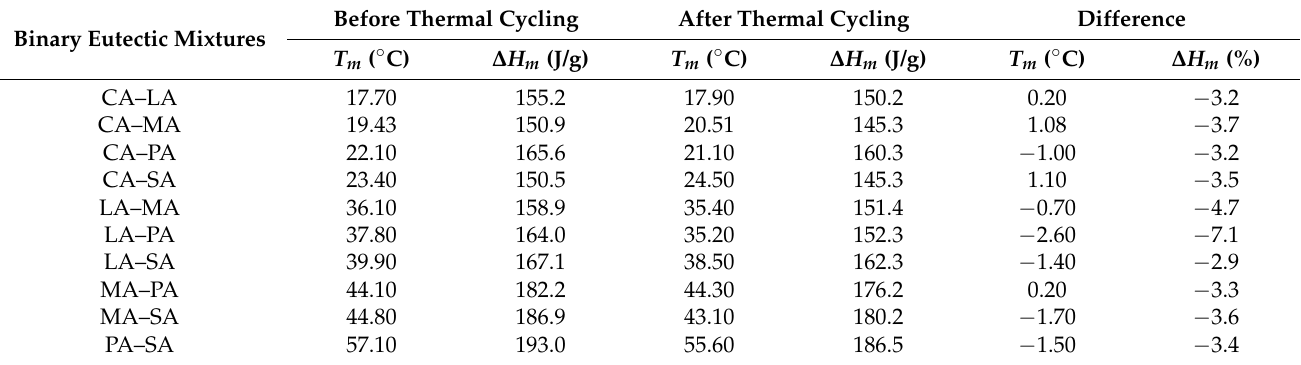
Table 7. T m and ∆ H m values of ten binary eutectic mixtures before and after 1000 thermal cycling.